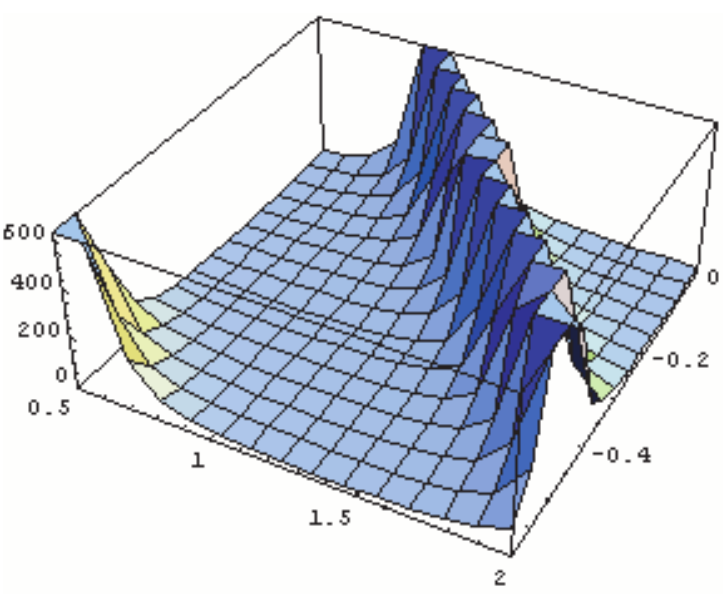
Fig. 6 Solution (66) with k = 0 , C = 10 4 for the Fisher equation (57).